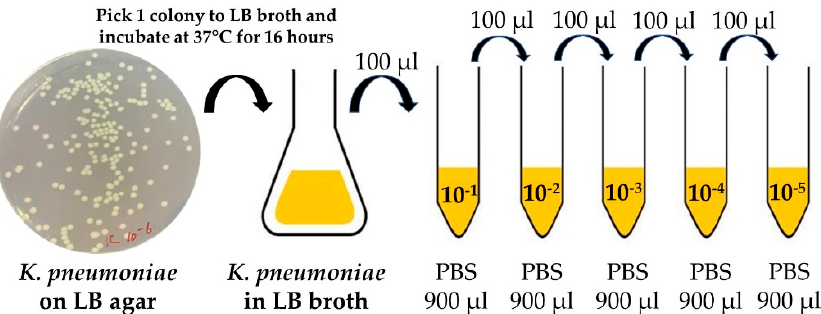
Figure 1. Schematic representation of K. pneumoniae on LB agar and the serial dilution